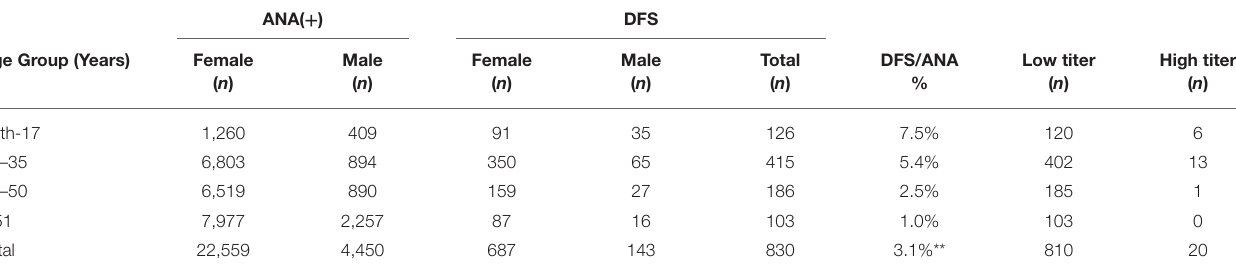
TABLE 2 | Characteristics of ANA-positive sera showing DFS pattern among different age groups.